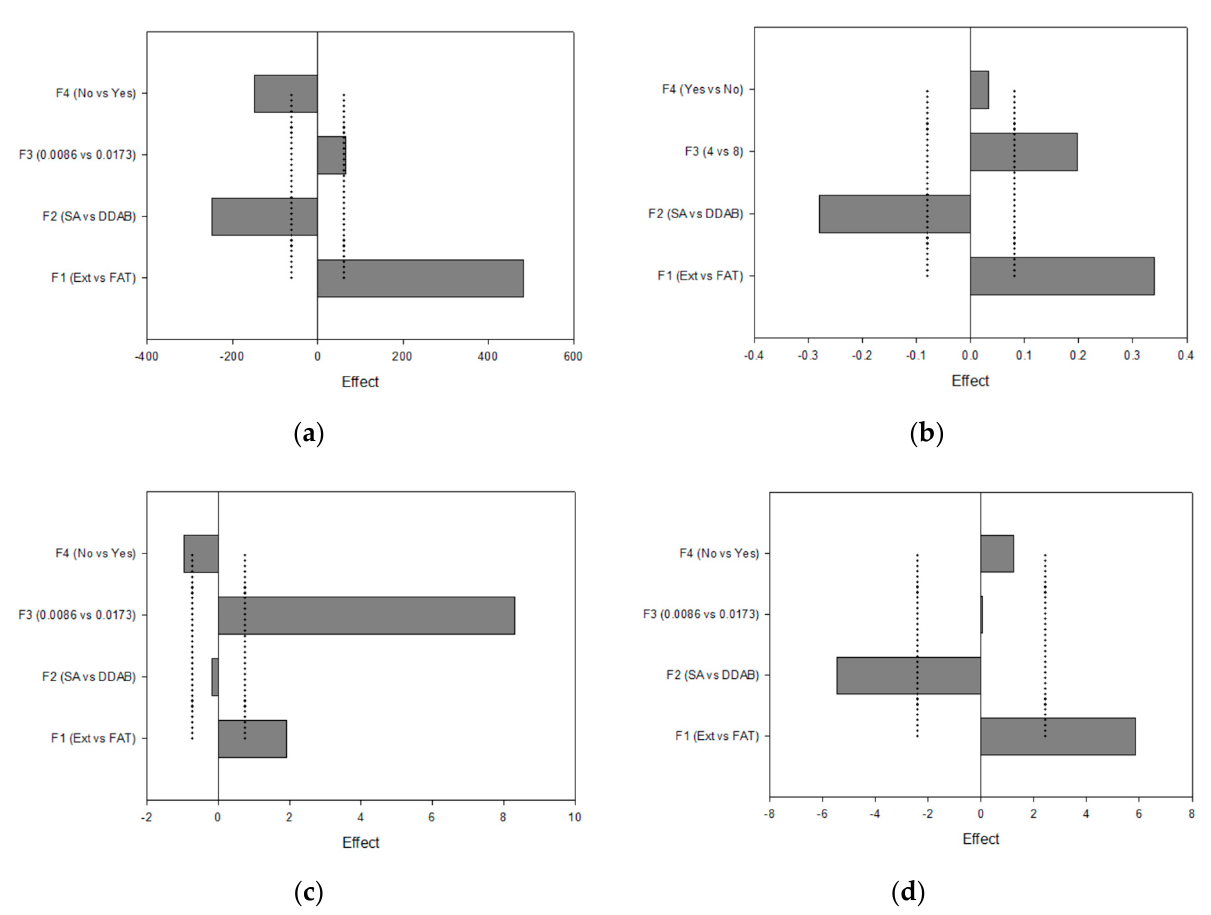
Figure 4. Pareto charts plotting the I-hat effects for ( a ) d H ; ( b ) PdI; ( c ) ZP; ( d ) EE Acz. Table 5. Selected levels for each factor, which were extracted from the Pareto analysis and for which the different responses in the sense of minimizing d H (size) and maximizing PdI